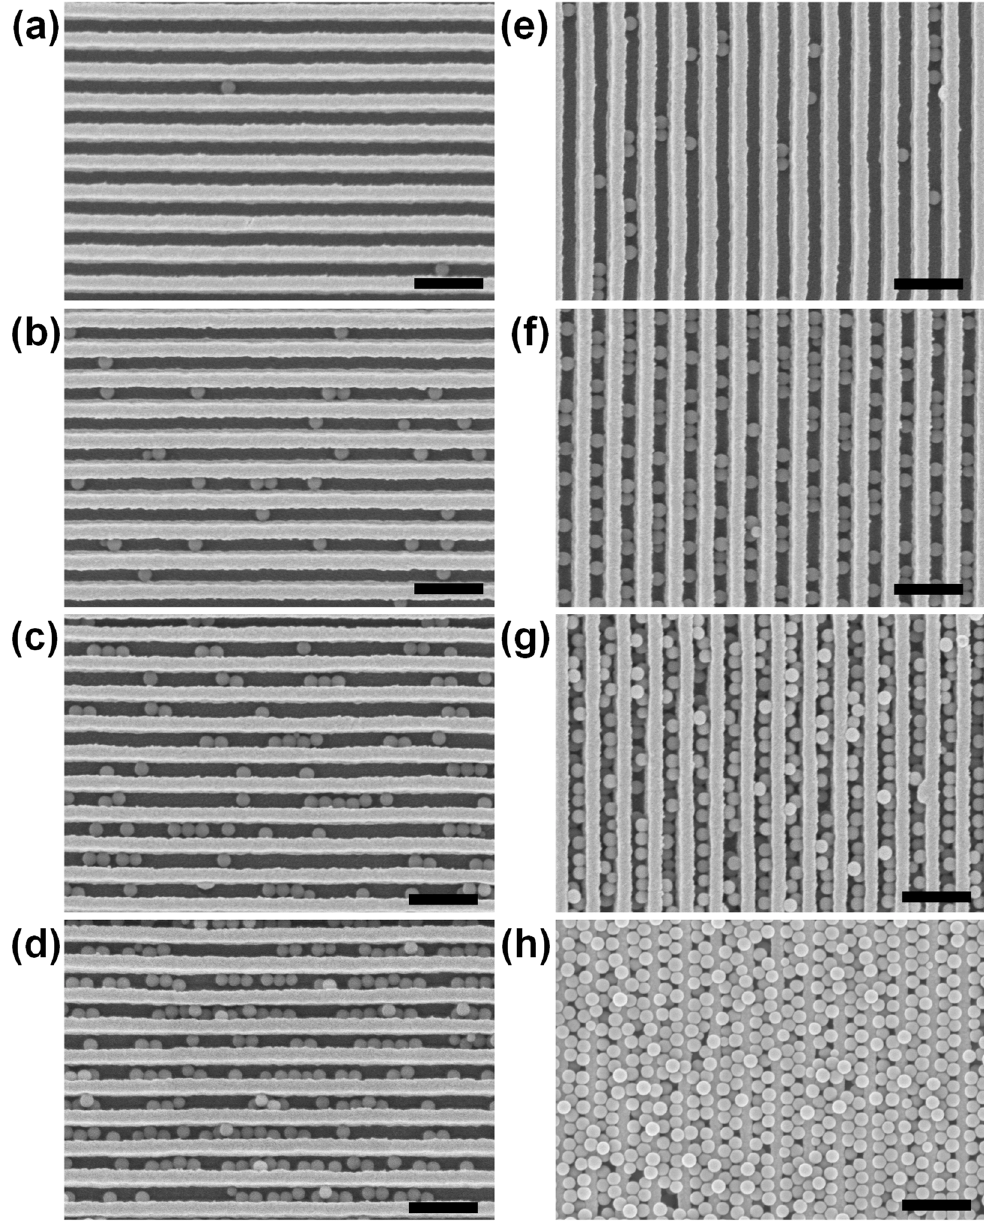
Figure 2. SEM images of the polystyrene (PS) bead-coated sample surfaces according to the direction and number of repeated dip-coating cycles. The dipping and pulling directions of DAS arrays were ( a – d ) perpendicular and ( e–h ) parallel to the direction of the length of Au strips. Samples were dip-coated ( a , e ) once, ( b , f ) three times, ( c , g ) five times, and ( d , h ) seven times. Scale bars represent 500 nm.